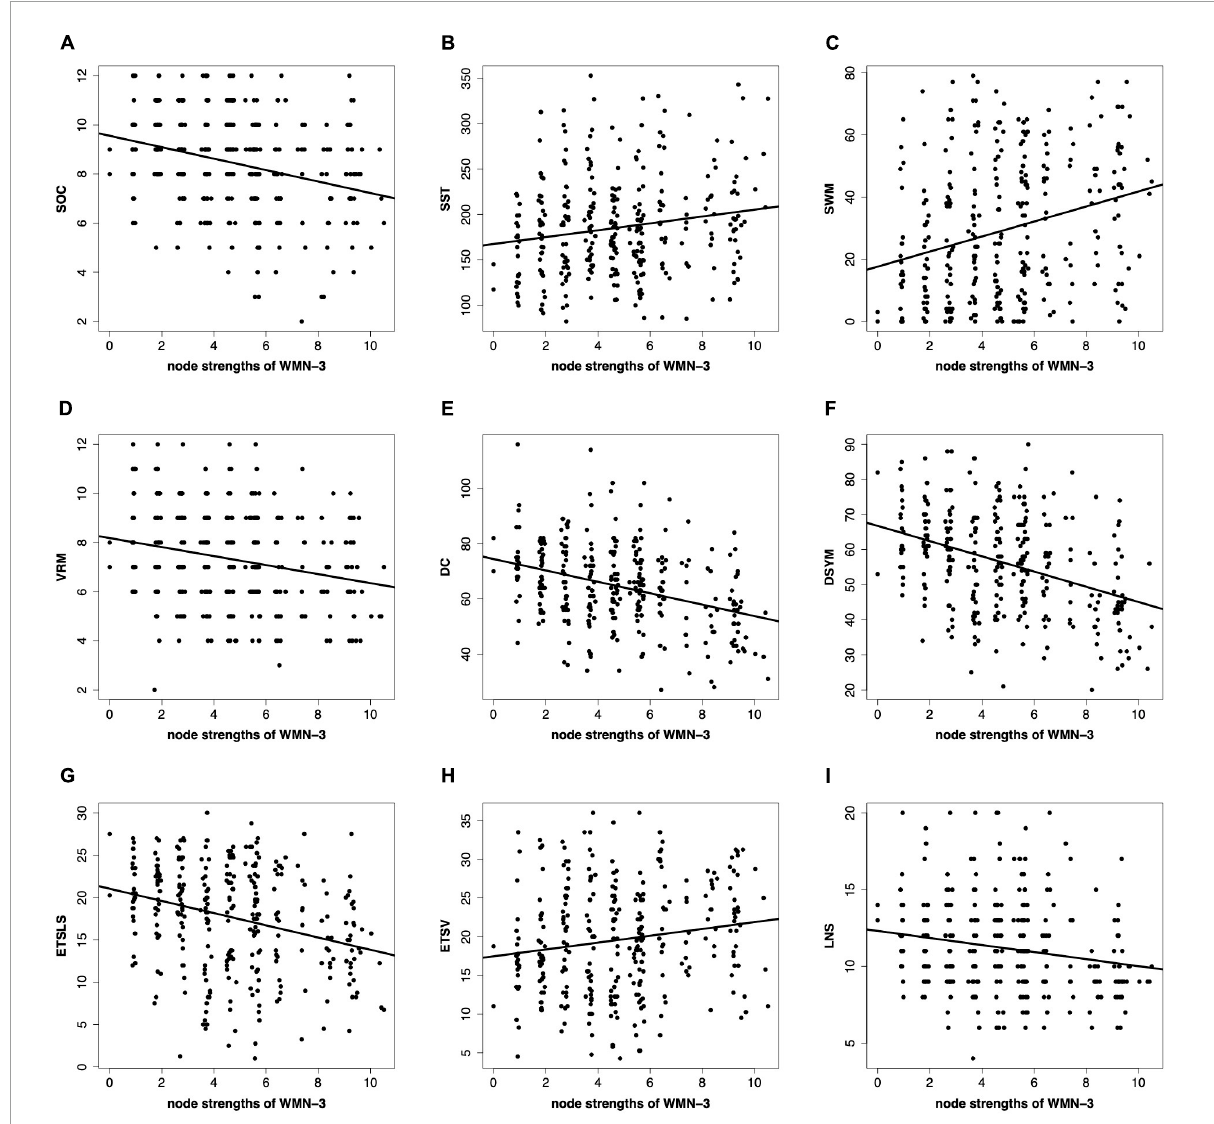
FIGURE6 Correlations between the node strengths and cognitive scores. (A–I) Denote the nine cognitive tasks. The nine cognitive tasks contain the Stockings of Cambridge (SOC), the stop signal task (SST), the spatial working memory (SWM), the verbal recognition memory (VRM), the digit comparison (DC), the digit symbol (DSYM), the ETS advanced vocabulary (ETSV), the ETS letter sets (ETSLS), and letter number sequencing (LNS), respectively. The node strengths are based on the sensorimotor-related white matter network